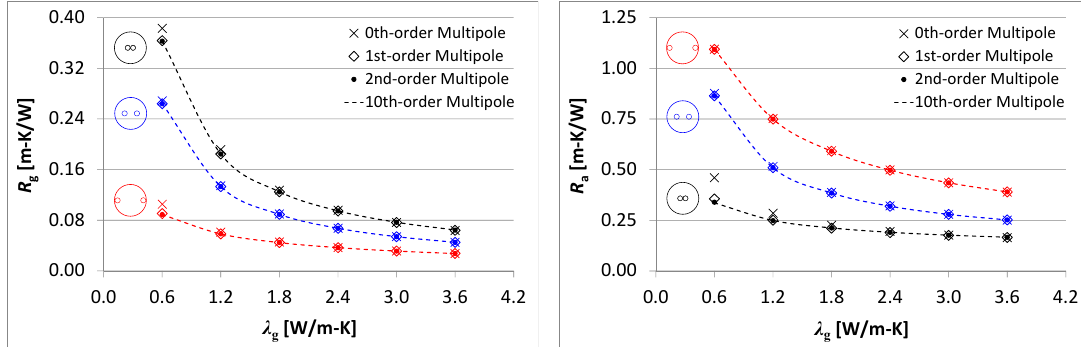
Figure 6. Grout thermal resistance ( R g ) and total internal resistance ( R a ) for close (2 x p = 32 mm), moderate (2 x p = 75 mm) and wide (2 x p = 160 mm) configurations with 2 r b = 192 mm and λ = 4